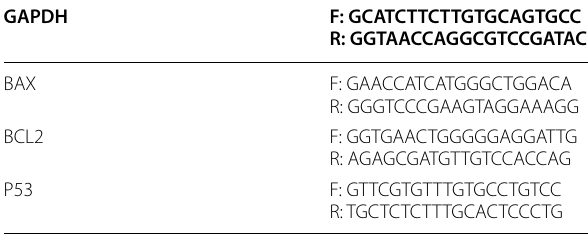
F forward primer, R reverse primer